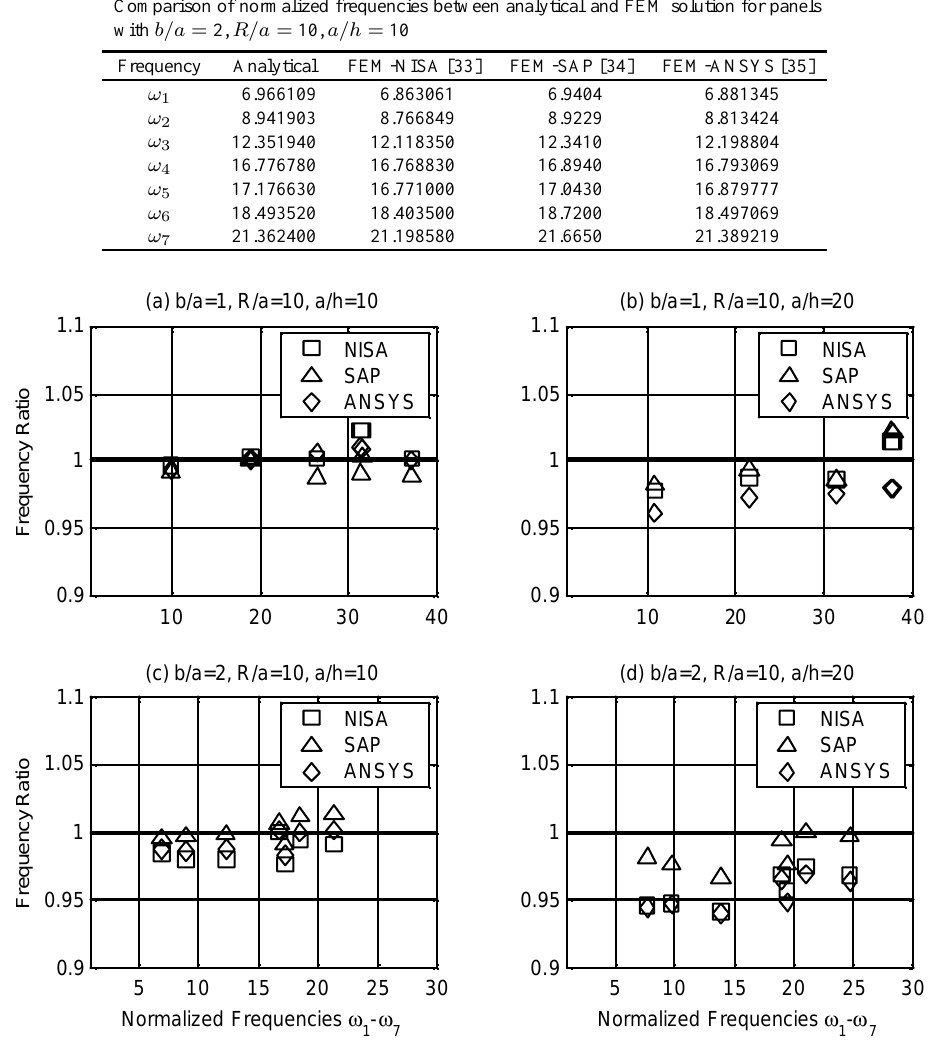
Table 3 Comparison of normalized frequencies between analytical and FEM solution for panels